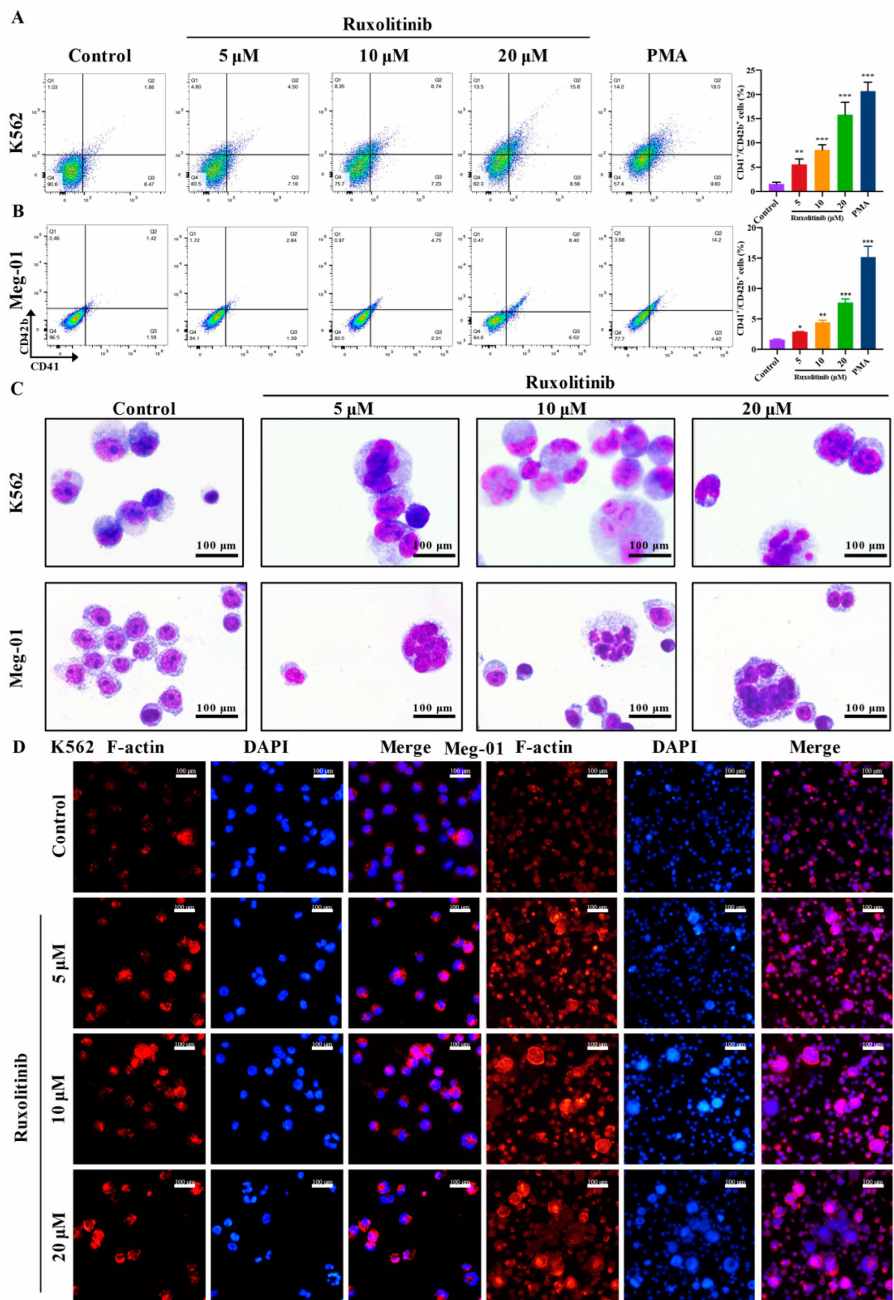
Figure 2. Ruxolitinib induces dramatic morphological changes and differentiations. ( A , B ) The per‑ centage of CD41 + /CD42b + complexes surface expression on K562 and Meg‑01 cells by ruxolitinib (5, 10 and 20 µ M) or PMA (2.5 nM) for 5 days and analyzed by flow cytometry; ( C ) Giemsa staining of K562 and Meg‑01 cells treated with ruxolitinib (5, 10, and 20 µ M). Magnification: 400 × , Scale bar: 100 µ m; ( D ) Phalloidin‑labeled cytospin in K562 and Meg‑01 cells on day 5 under a fluorescence Microscope (excitation wavelength: 560 nm for Phalloidin, 405 nm for DAPI). Magnification: 400 × , Scale bar: 50 µ m. n = 3, mean ± SD. Statistics were determined by one‑way ANOVA with Dunnett’s and two‑way ANOVA with Tukey’s 862 multiple comparisons test, * p < 0.05, ** p < 0.01, *** p < 0.001 vs. the